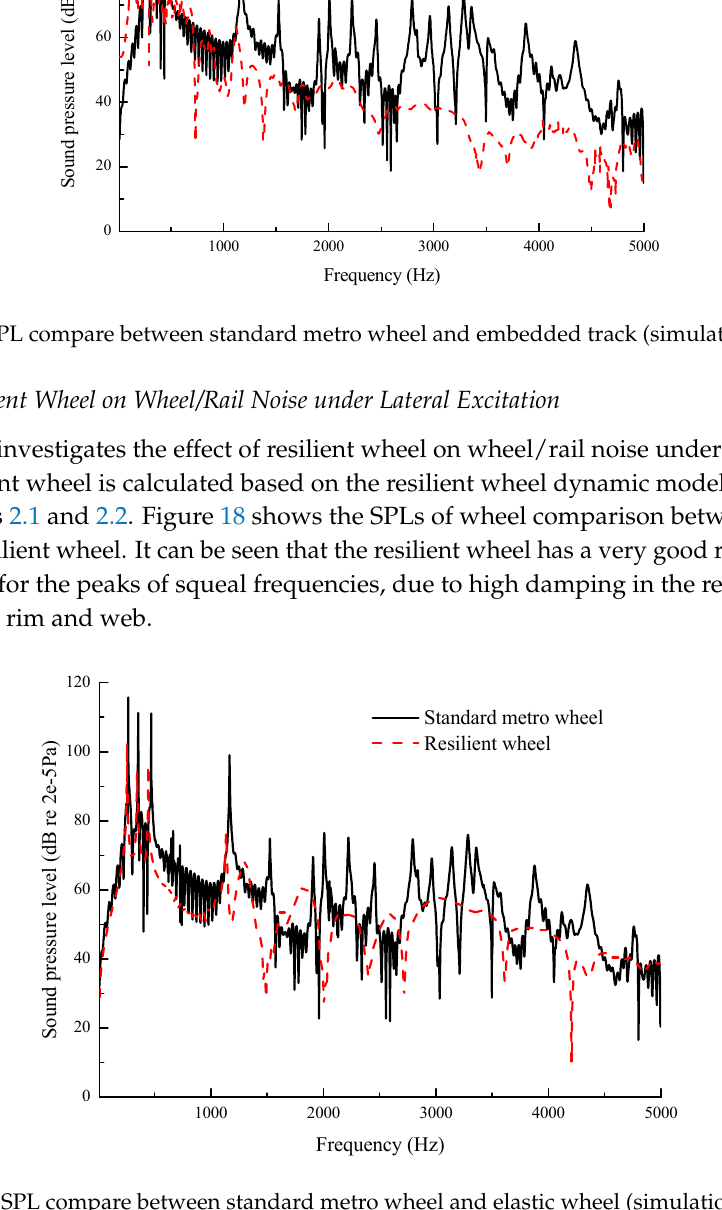
Figure 16. Total SPLs considering standard metro wheels coupled with the conventional slab track and embedded track (simulation results).